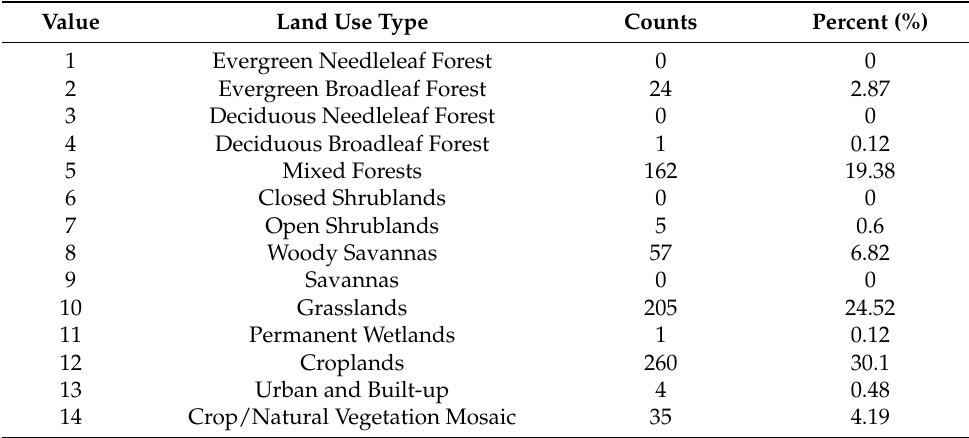
Table 1. The counts and percentages of observation stations at different